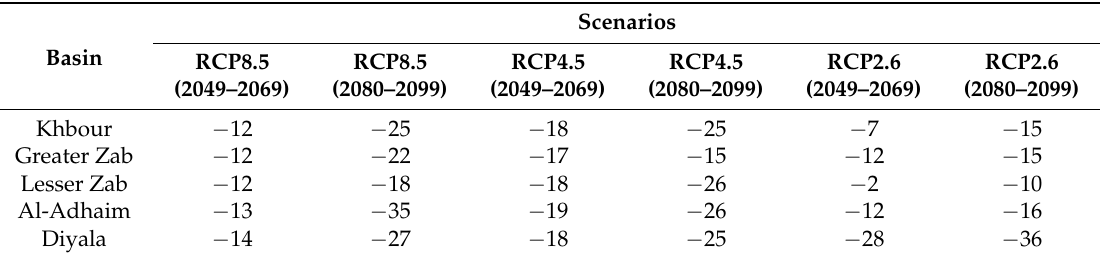
Table 6. The projected relative changes in precipitation for the five basins under RCP8.5, RCP4.5, and